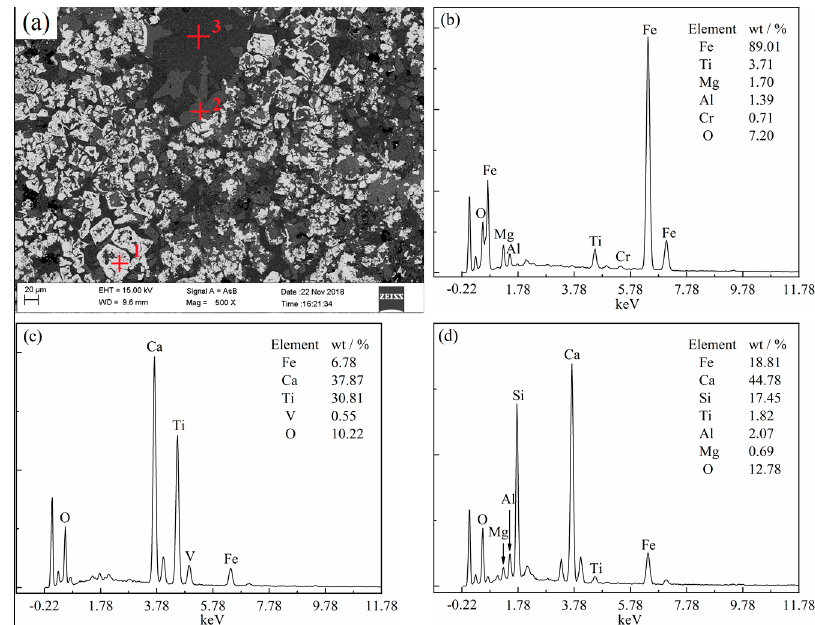
Figure 9. SEM image and EDS analysis of sinter after reduction at 900 °C for 3 h (basicity = 2.3). ( a ) SEM image; ( b ) point 1; ( c ) point 2; ( d ) point 3.